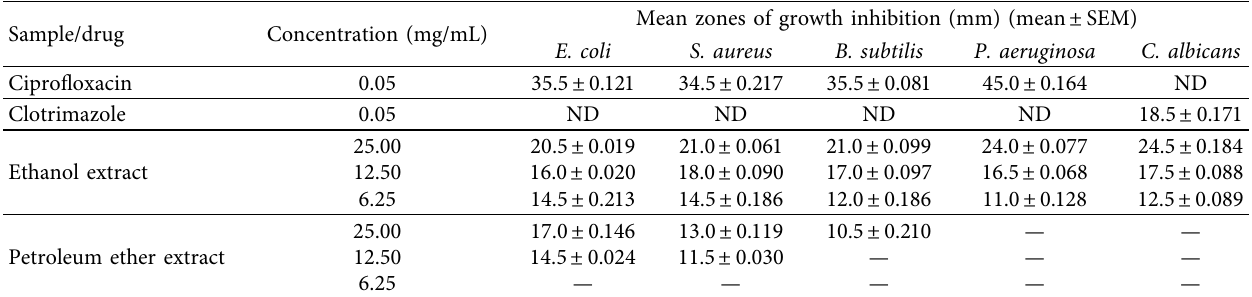
ND � not determined, the diameter of well